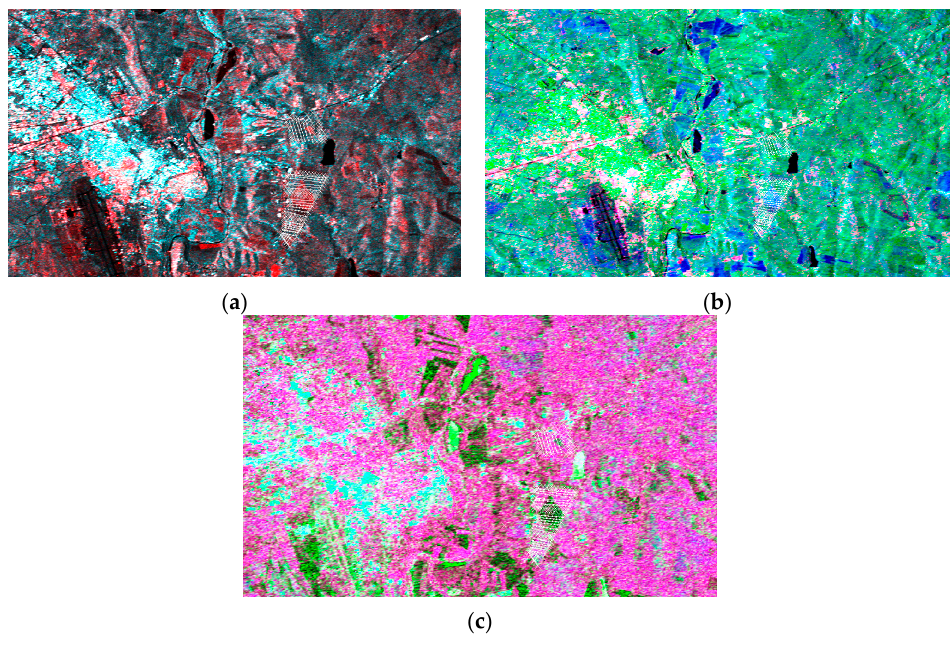
Figure 8. Radarsat-2 data from 8 April 2015 after ( a ) standard sigma backscattering technique; ( b ) Freeman–Durden; and ( c ) H/A/ α models.